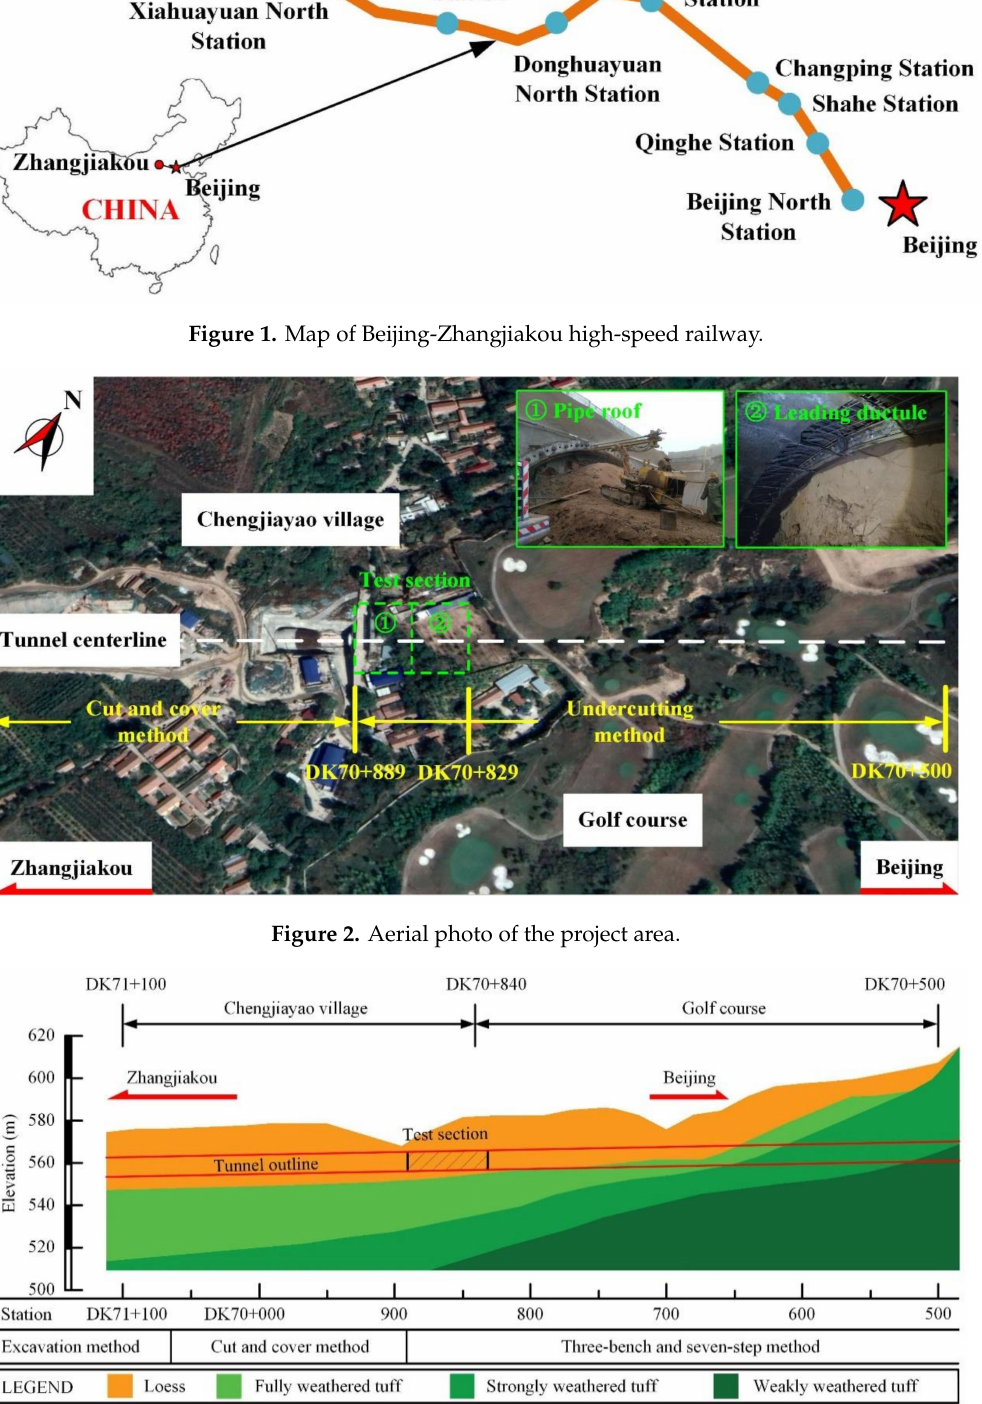
Figure 3. Longitudinal geological profile of northwest portal of New Badaling